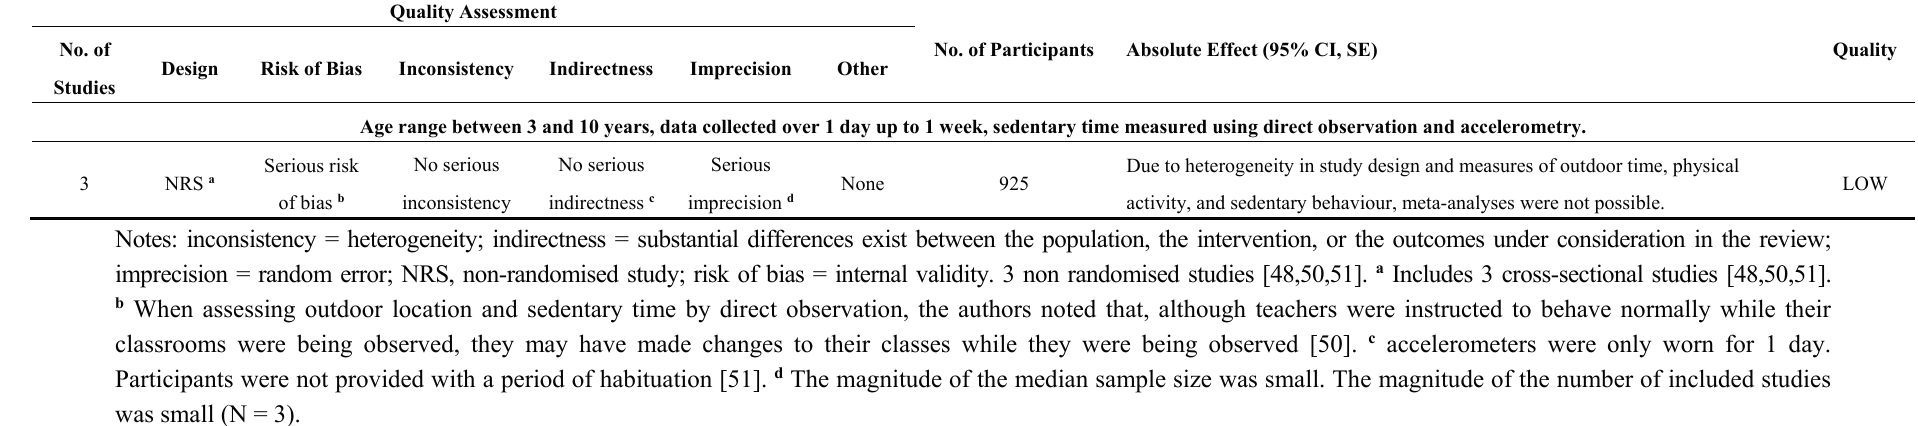
Table 5. Associations between outdoor time and motor